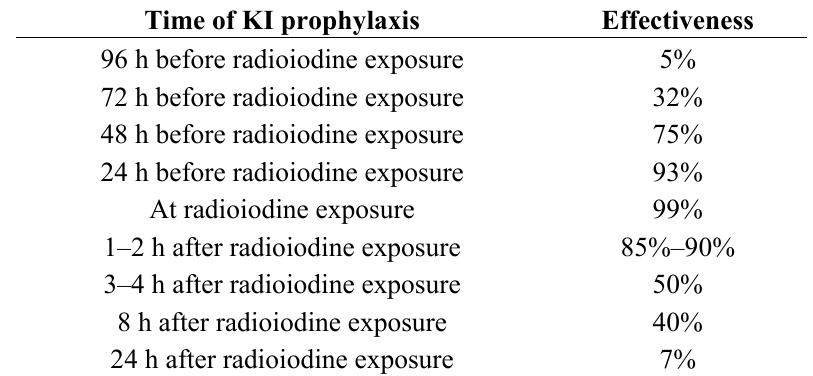
Table 1. The percentage efficacy of 100mg Potassium Iodide prophylaxis in relation to the time of administration and radioiodine